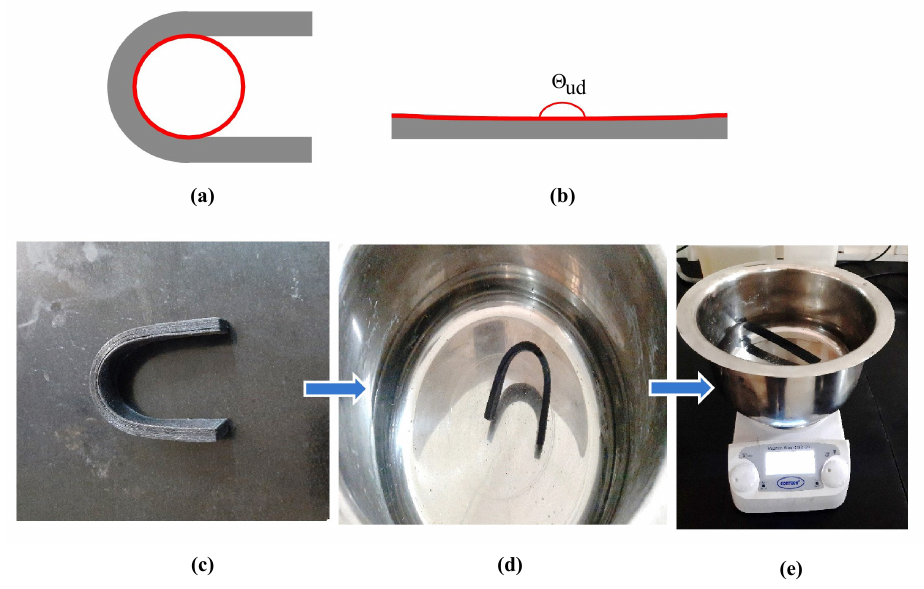
Figure 3. ( a ) Deformed and ( b ) permanent modes of specimens considered for evaluating shape recovery; ( c ) temporary deformed shape; ( d ) kept in a water bath above Tg; ( e ) shape recovery in a water